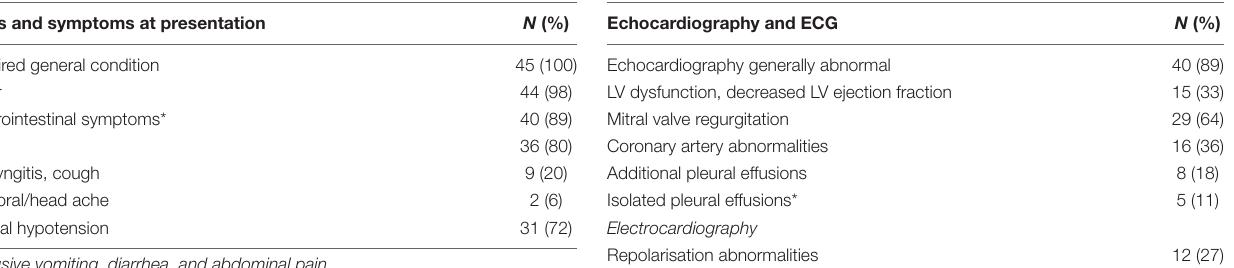
TABLE 2 | Signs and symptoms. TABLE 3 | Cardiac